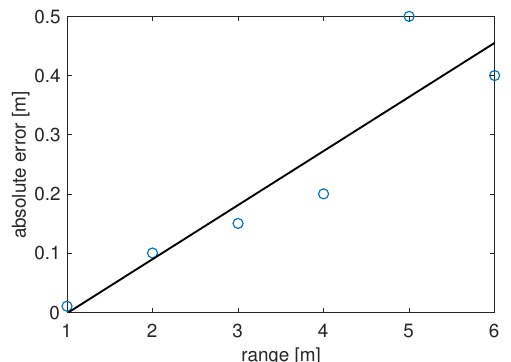
Figure 11. Absolute error as a function of the